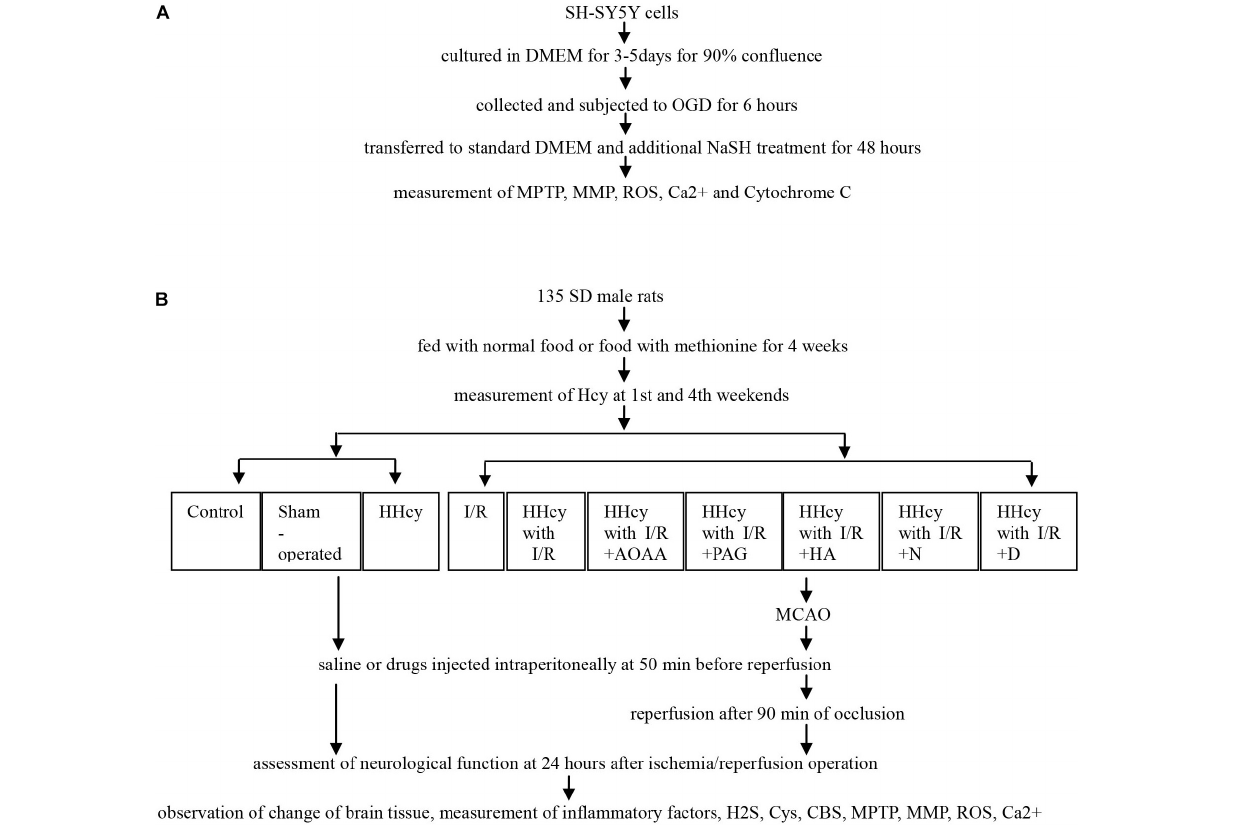
FIGURE 1 | Flowchart of experimental process. (A) SY5Y cells were cultured and subjected to OGD and different NaSH treatment, and then collected to measurement of MPTP, MMP, ROS, Ca 2 + and Cytochorme C. (B) SD males fed using normal food or food with methionine were divided into ten groups, and received MCAO or not, saline or inhibitor injected intraperitoneally, and finally assessed for neurological function, morphological change and cytokines levels. *HHcy, hyperhomocysteinemia; I/R, ischemia/reperfusion; AOAA, aminooxyacetic acid; PAG, DL-propargylglycine; HA, hydroxylamine; N, N-anandamide; D, Pyrrolidine dithiocarboxylic acid ammonium